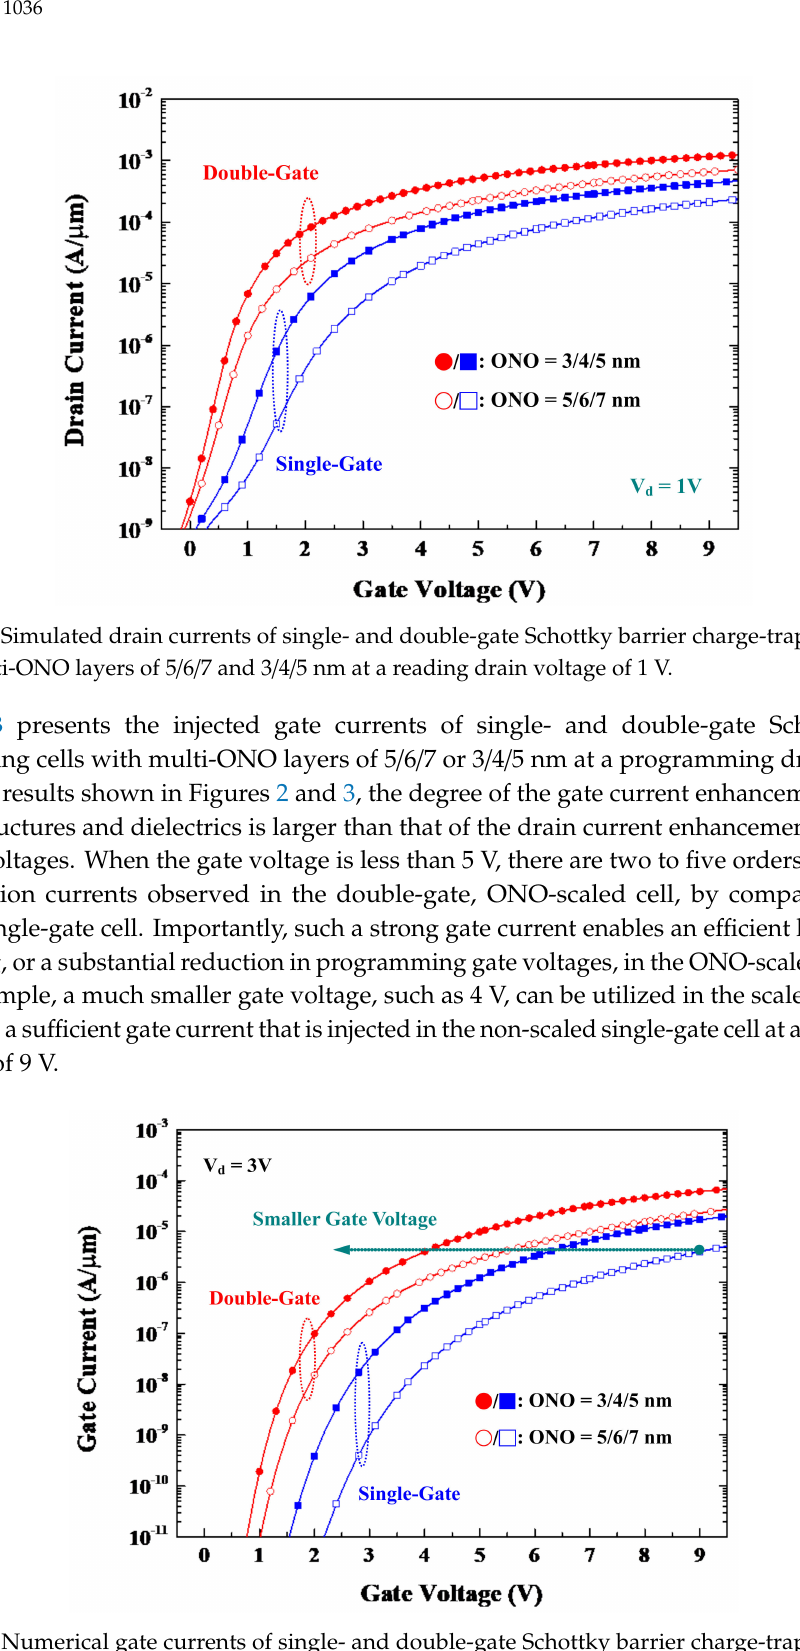
Figure 3. Numerical gate currents of single- and double-gate Schottky barrier charge-trapping cells with multi-ONO layers of 5 / 6 / 7 and 3 / 4 / 5 nm at a programming drain voltage of 3